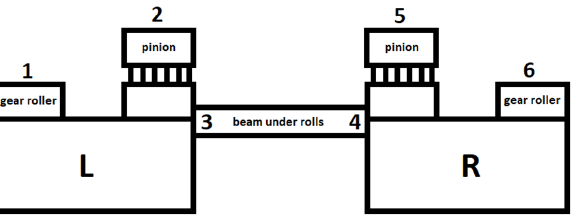
Figure 6. Diagram of the gantry drive system with location of vibration sensors (1 to